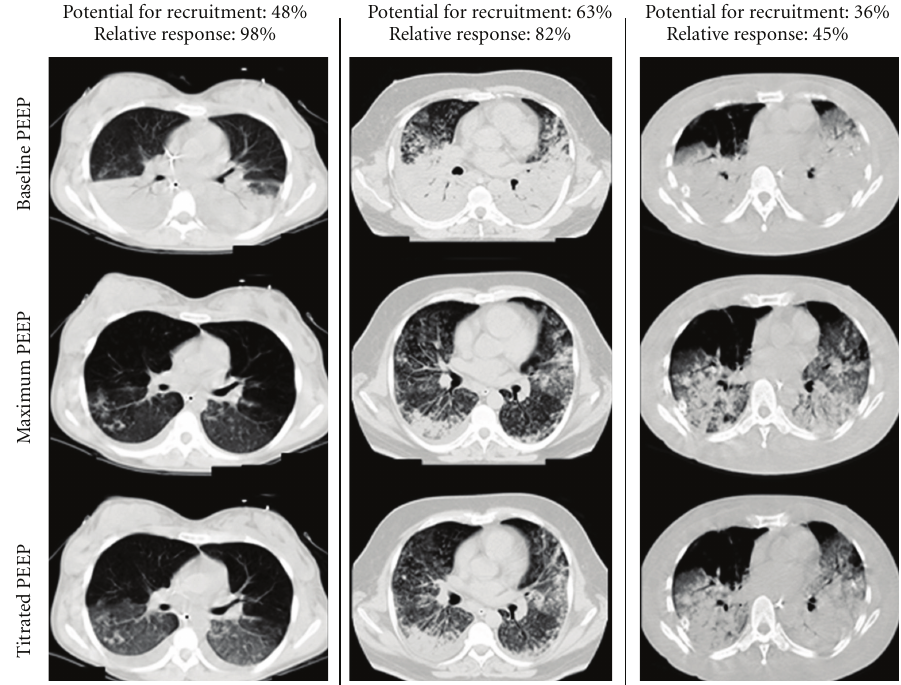
Figure 1: Computer tomographic evaluation of maximal recruitment strategy and adequate PEEP titration in early severe ARDS patients.